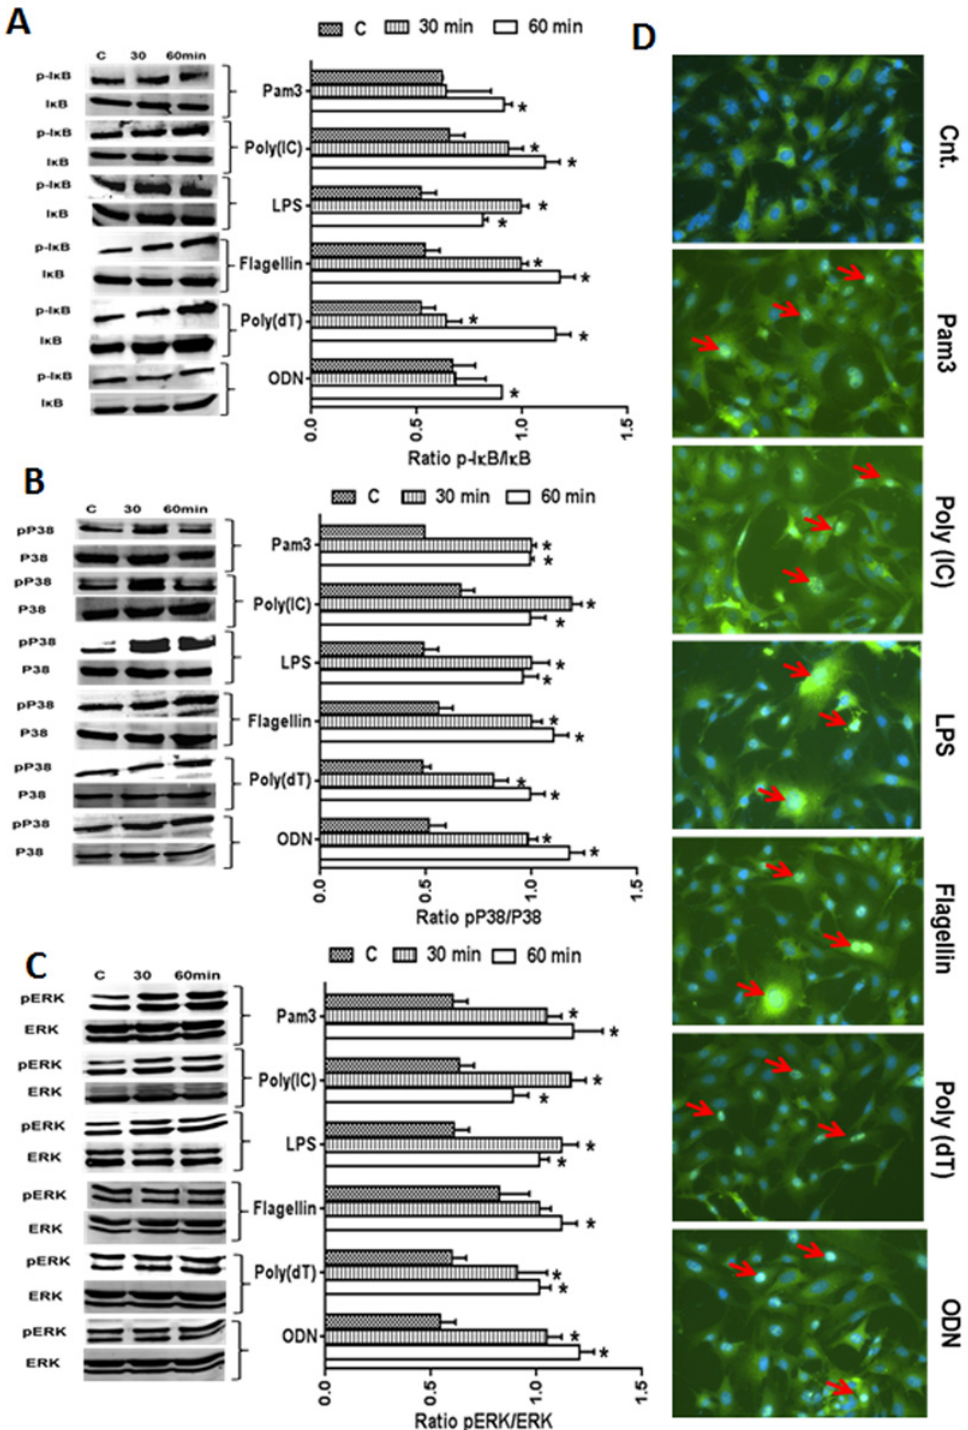
Fig 3. Activation of TLR-downstream (NF-kB and MAPK) signaling following TLR agonist stimulation. In order to assess the activation of IkB, p38, and ERK signaling following stimulation with TLR agonists for 30 and 60 min., 661W cells were lysed in RIPA buffer and analyzed by Western blot analysis using antibodies against phospho-IkB (p-IkB), p-p38, and p-ERK. Antibodies against ERK, p38, and IkB were used to detect total protein levels (A-C). Band intensity was quantified using Image J and presented as the relative band intensity of the phosphorylated form vs. the total form for the respective proteins (A- C). To detect the nuclear translocation of NF-kB (p65), 661W cells were challenged for 60 min. with various TLR ligands. Cells were then fixed,